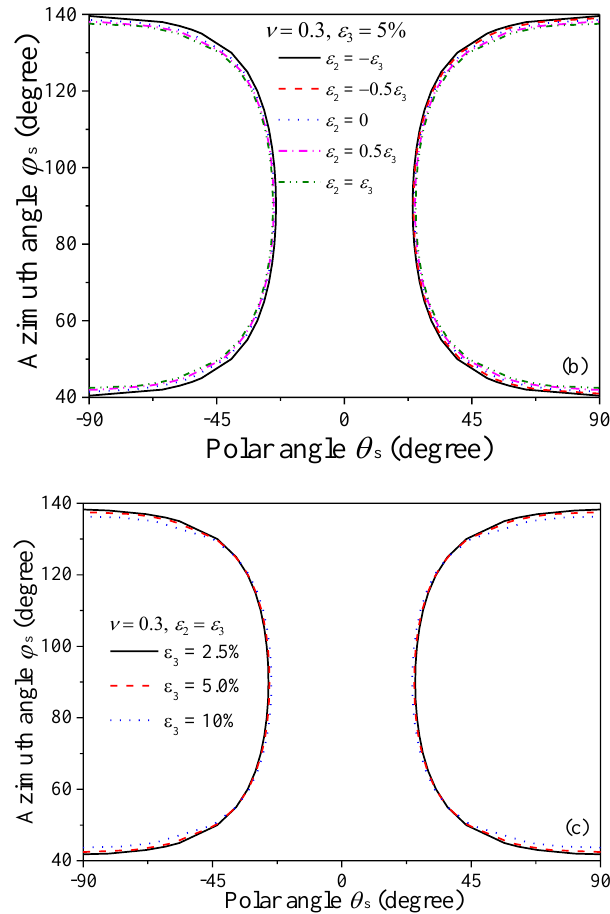
Figure 5. Critical Euler angles ( a ) Different Poisson’s ratios; ( b ) Different strain ratios; ( c ) Different stretching strains.